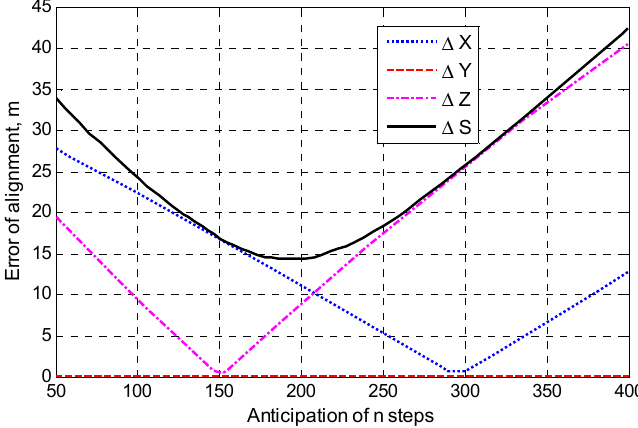
∆ X , ∆ Y , ∆ Z , ∆ S and the initial lead steps n